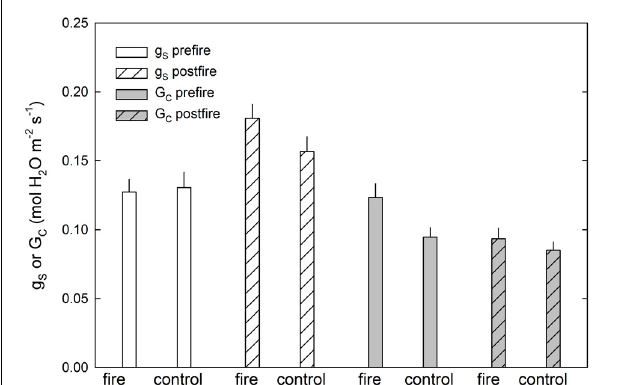
FIGURE 2 | P. rigida canopy and leaf level stomatal responses to prescribed fire at the 2011 fire site, Brendan T Byrne Forest, see also Renninger et al.